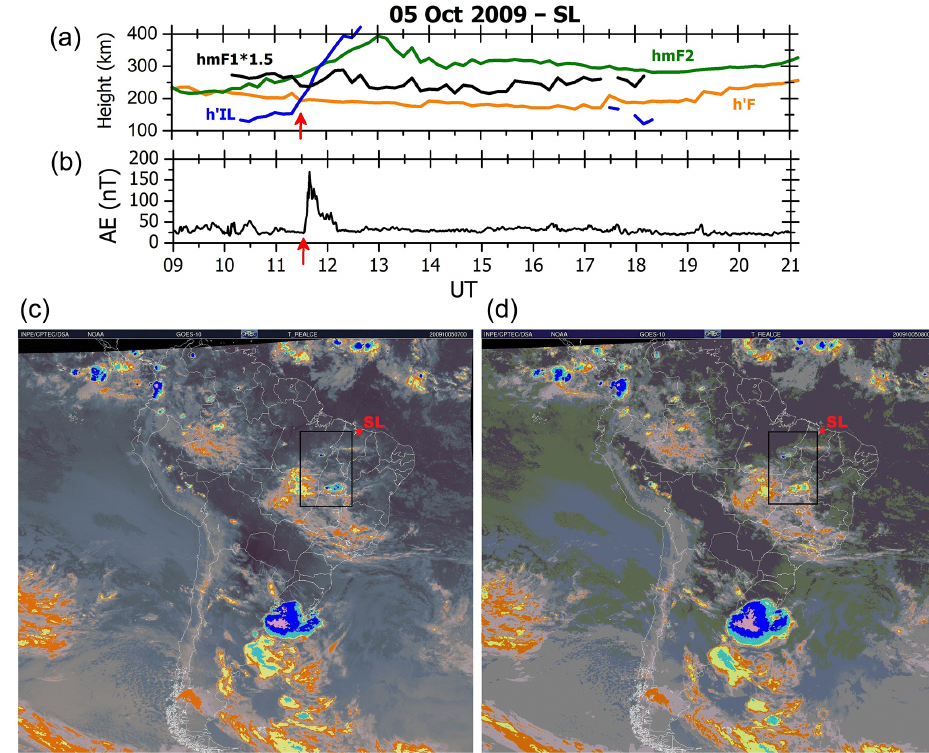
Figure 9. Ascending intermediate layer over SL during 5 October. The first panel (a) – (d) shows the virtual height of the F layer ( h (cid:48) F, orange line), the F1 and F2 layer peak (hmF1 and hmF2, black and green lines, respectively), and the virtual height of ILs ( h (cid:48) IL, blue line). For a better visualization of the phenomena in discussion, the hmF1 parameter was multiplied by a factor of 1.5. The second panel shows the auroral activity index AE indicating the possible influences of prompt penetration electric field. Images from GOES satellite for 07:00 and 08:00UT, showing the convective zones near São Luis (as indicated by the black rectangle), are shown in the last